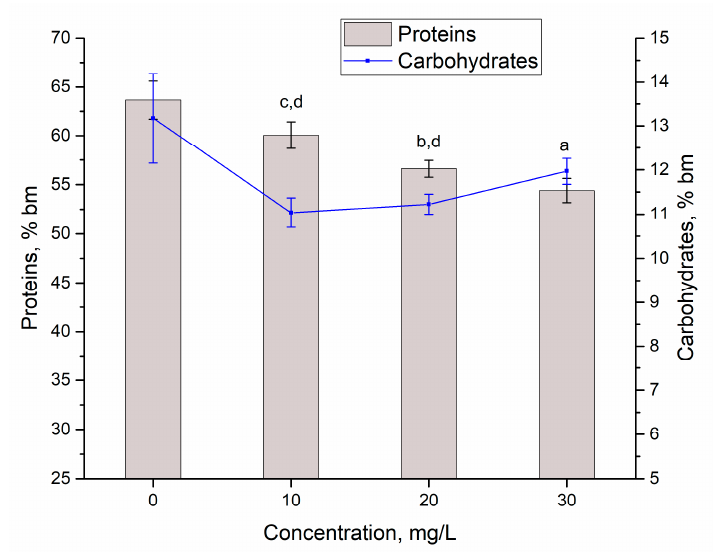
Figure 4. The content of proteins and carbohydrates in Arthrospira platensis exposed to Y(III) in concentrations of 10–30 mg/mL (a— p < 0.0005, b— p < 0.005, c— p < 0.05 for the difference between the experimental sample and control—proteins; d— p < 0.05 for the difference between the experimental sample and control—carbohydrates).